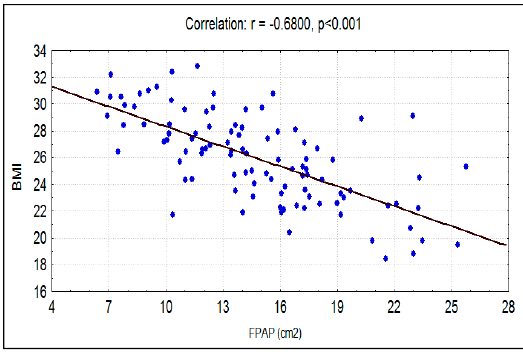
Figure 5. Correlation between BMI with FPAP (per cm 2 ) in smokers.